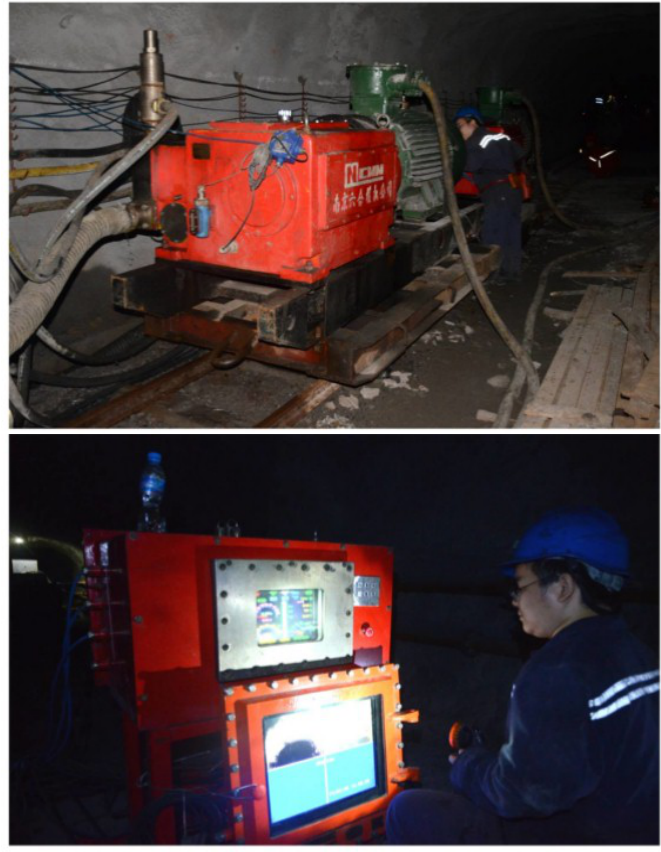
Figure 8. Field test of cross-measure hydraulic fracturing in underground